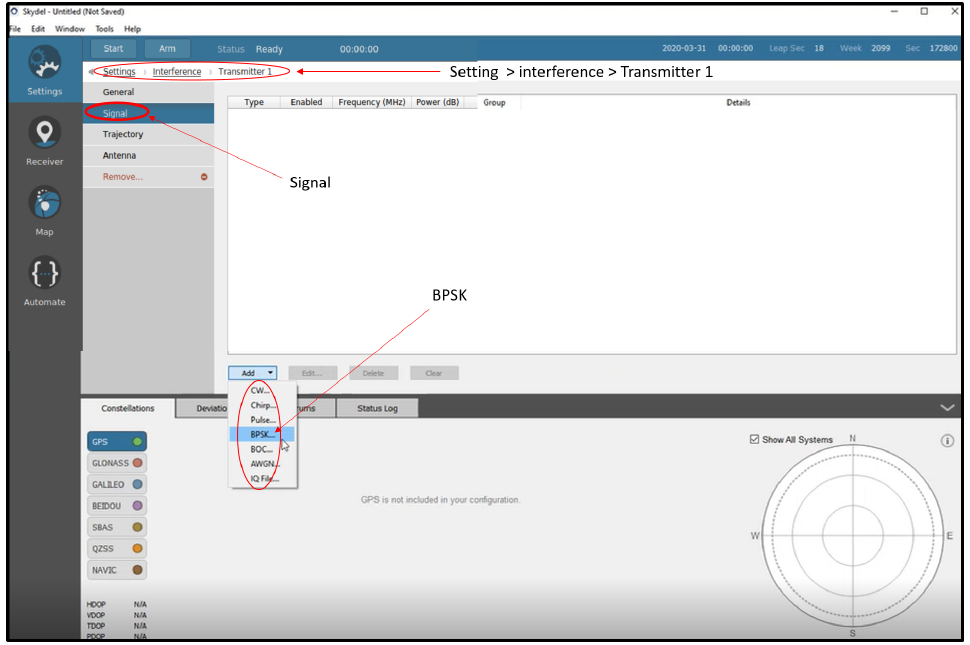
Figure 3. Selection of interference signal.